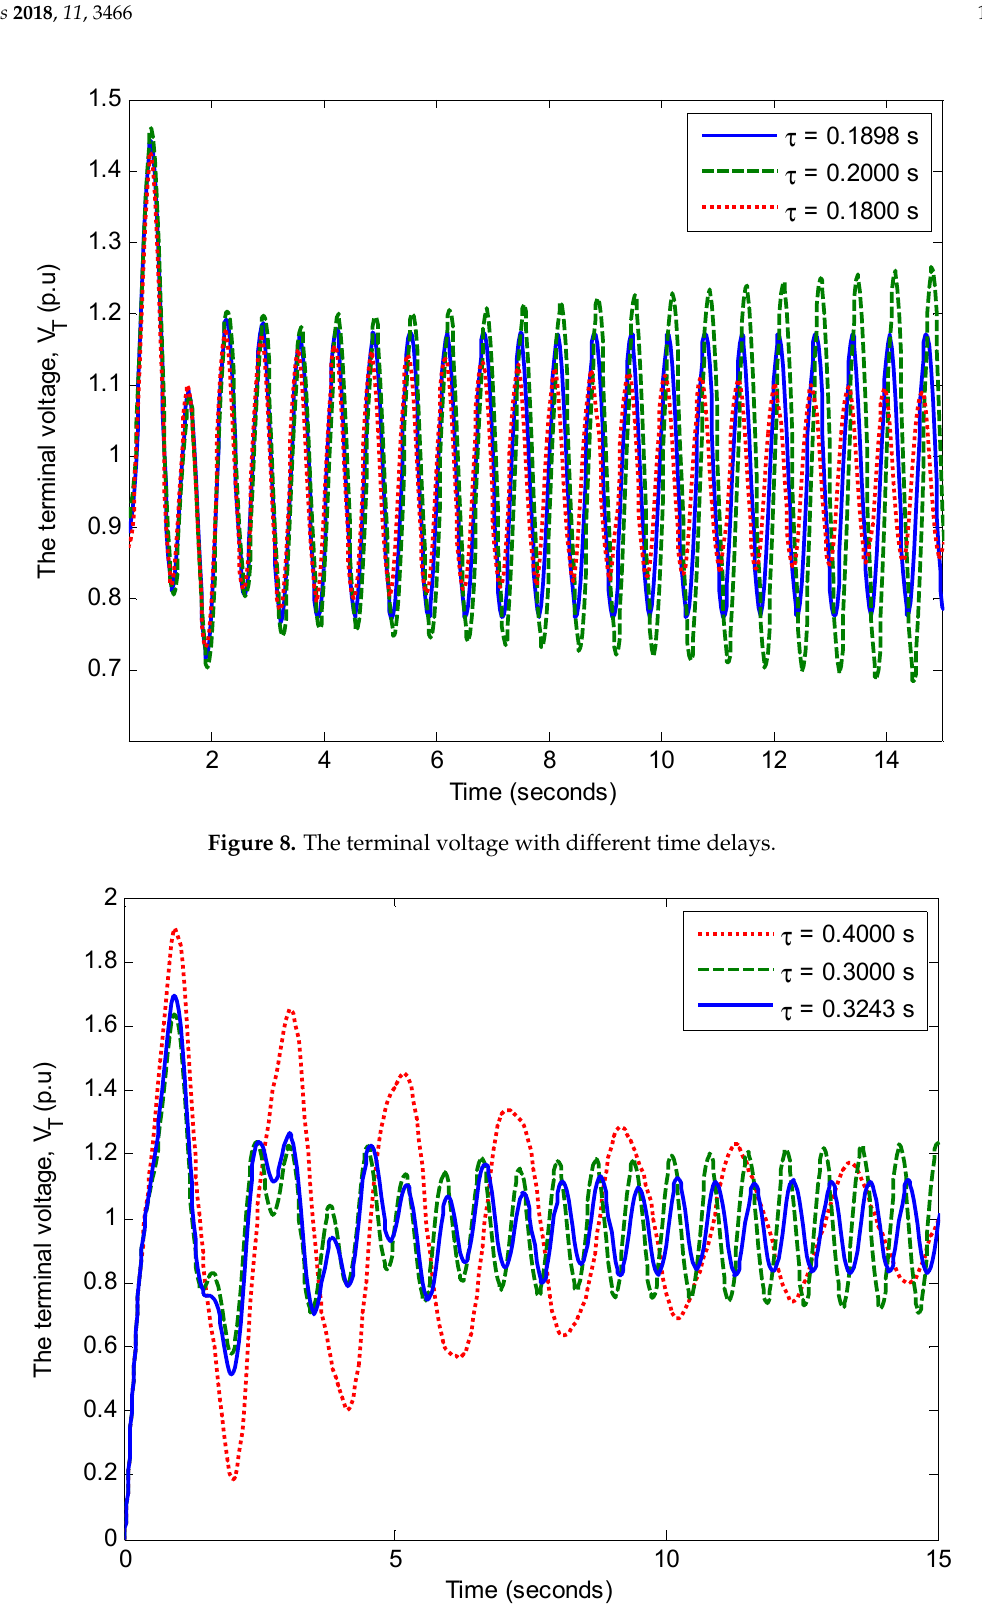
Figure 7. The spectral radius as function of ω .